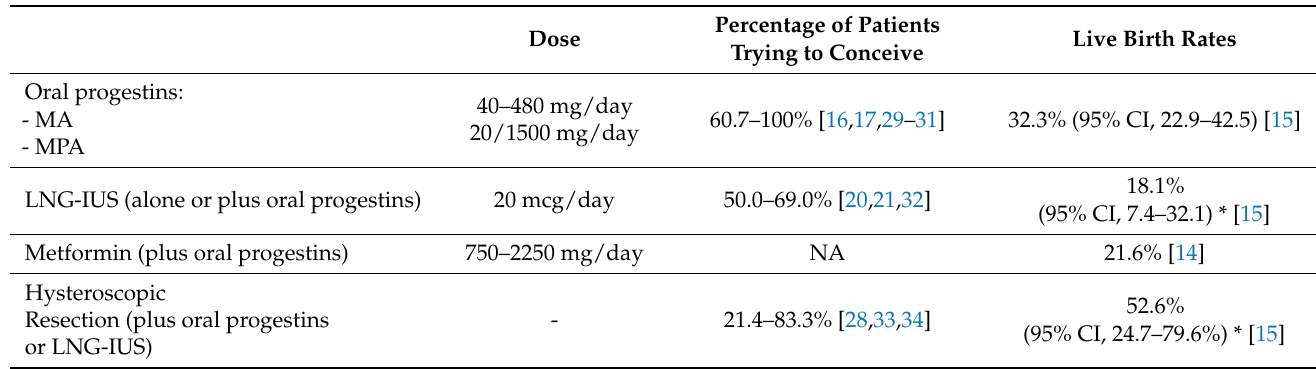
Table 2. Fertility outcomes after fertility-sparing